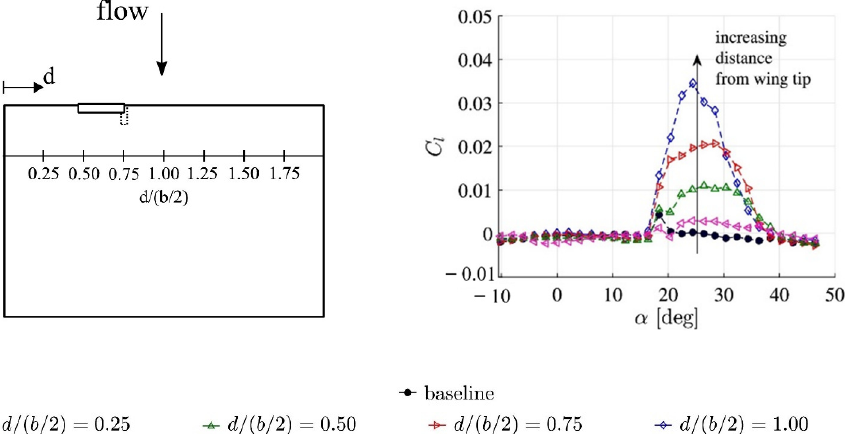
Figure 10. Effect of the spanwise distance of a single alula from the left wing tip on the roll moment coefficient curves of an AR = 1.5 rectangular wing [22].